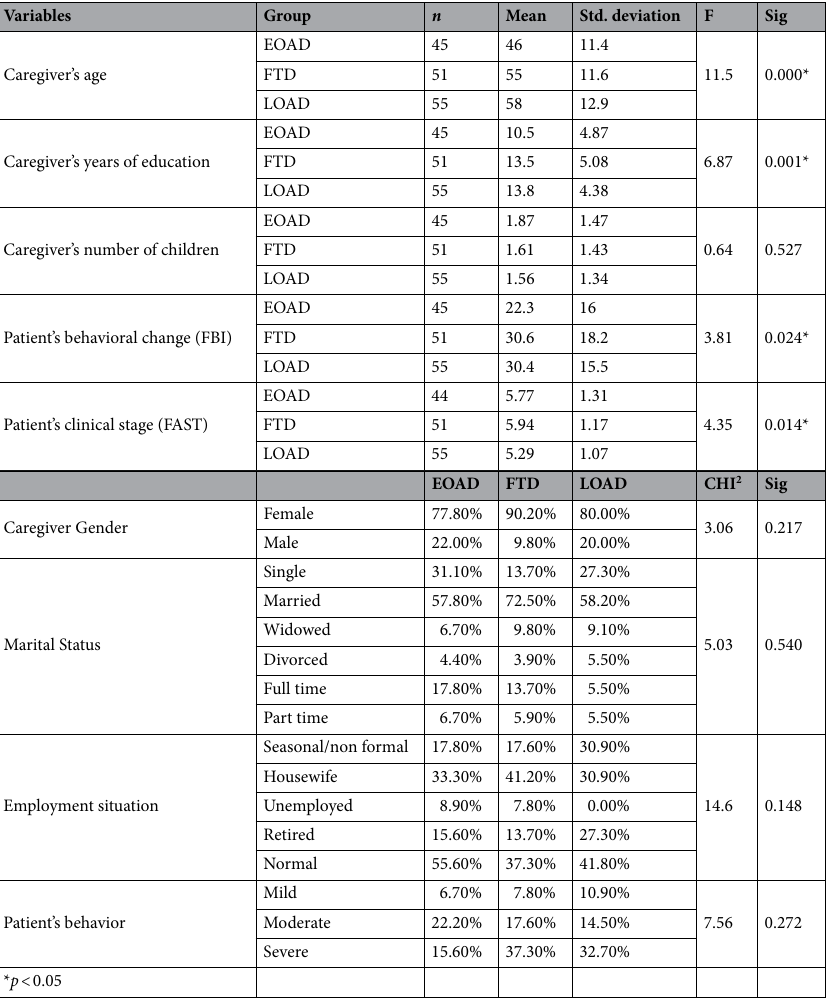
analyze what variables (sociodemographic factors, type of dementia or diagnostic group, behavioral changes, dementia stage, and family stigma) explained better caregiver´s outcomes such fatigue/energy for QoL, emo- tional wellbeing for QoL, caregiver burden and anxiety trait (Table 3). Before running the multivariate analysis of covariance (MANCOVA), we assessed assumptions for linear models. The dependent variables were continuous and linear and had normal distributions based on graphical inspection and statistical methods (Kolmogorov– Smirnov and Shapiro–Wilk tests). All variables are normally distributed and independent observations. There were no outliers. We explored linearity between the dependent-independent variables and found suitable pat- terns to move on to assess the homogeneity of regression slopes. There were no significant interactions. Using Wilks’ criterion, we found significant differences in family stigma (Wilk’s Λ = 0.52, F (4, 131) = 30, p < 0.001), diagnostic group (Wilk’s Λ = 0.88, F (8, 262) = 2.20, p = 0.028) and behavioral change FBI (Wilk’s and all outcomes, it means that family stigma was the only variable associated with the presence of lower energy, reduction in emotional wellbeing, higher caregiver burden and anxiety trait. Furthermore, behavioral changes were also able to explain an increase in caregiver burden. We analyzed the parameter estimates for associations among the outcomes, factors, and covariates (Table 3). To measure the risk of negative psychological outcomes due to family stigma among caregivers we calculated the odds ratio (OR). For QoL (Energy/fatigue and emotional wellbeing), caregiver burden and anxiety trait. Our findings show that after controlling for age, education, clinical stage, and behavioral changes family stigma increased the risk for all outcomes except for anxiety. For Qol. (Energy/fatigue) we found that stigma explained 28% of the variance (OR 1.11, 95% IC: 1.06–1.17 P < 0,001). For Qol. (emotional wellbeing) stigma explained 28% of variance (OR 1.10, 95% IC: 1.05–1.15 p < 0,001). For Caregiver burden explained 46% of the variance (OR 1.23, 95% IC: 1.13–1.34 p < 0,001).